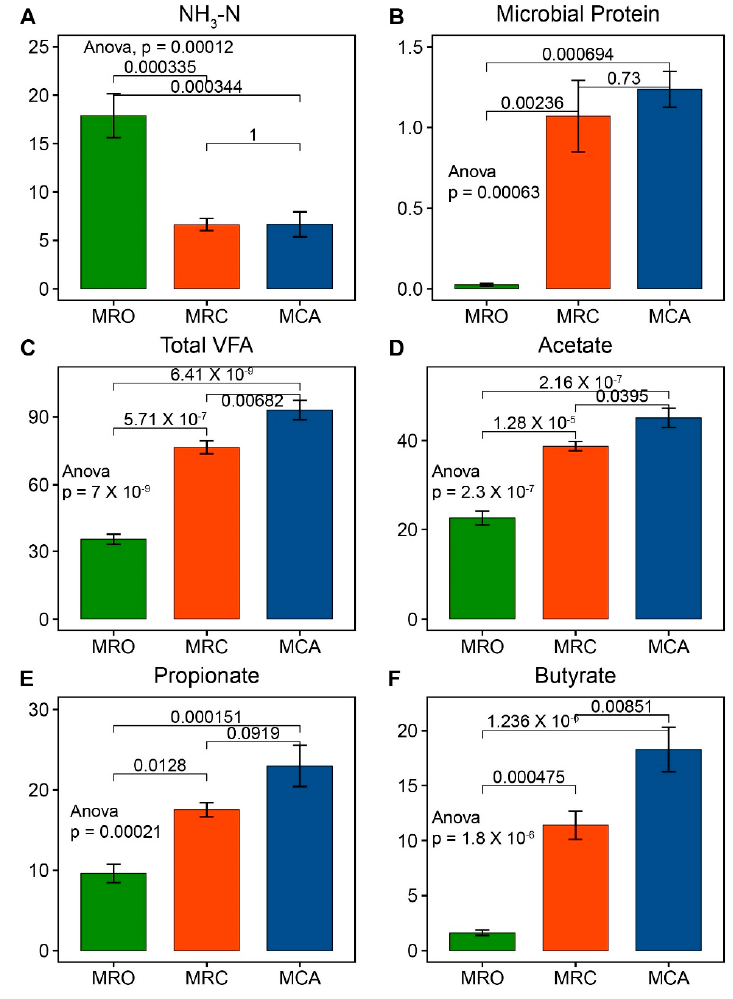
Figure 1. Effects of early supplementary solid diet on rumen fermentation parameters in goat kids. The significant differences of rumen NH 3 -N ( A ), microbial proteins ( B ), total VFA ( C ), acetate ( D ), propionate ( E ) and butyrate ( F ) were found. An Anova test was used for significance calculation after detection of homogeneity of variance. After the global test was significant, a post-hoc analysis (Tukey’s HSD test) was performed to determine which group of the independent variable differ from each other group. High dietary nitrogen conversion ratio was found in MRC and MCO ( p < 0.05). The total VFA, acetate propionate and butyrate had the highest values in MCA ( p < 0.05), and were significantly higher in MRC than in MRO ( p < 0.05). MRO = milk replacer only, MRC = milk replacer + concentrate, MCA = milk replacer + concentrate + alfalfa. VFA: Volatile fatty acids. Statistical significance was accepted at p <